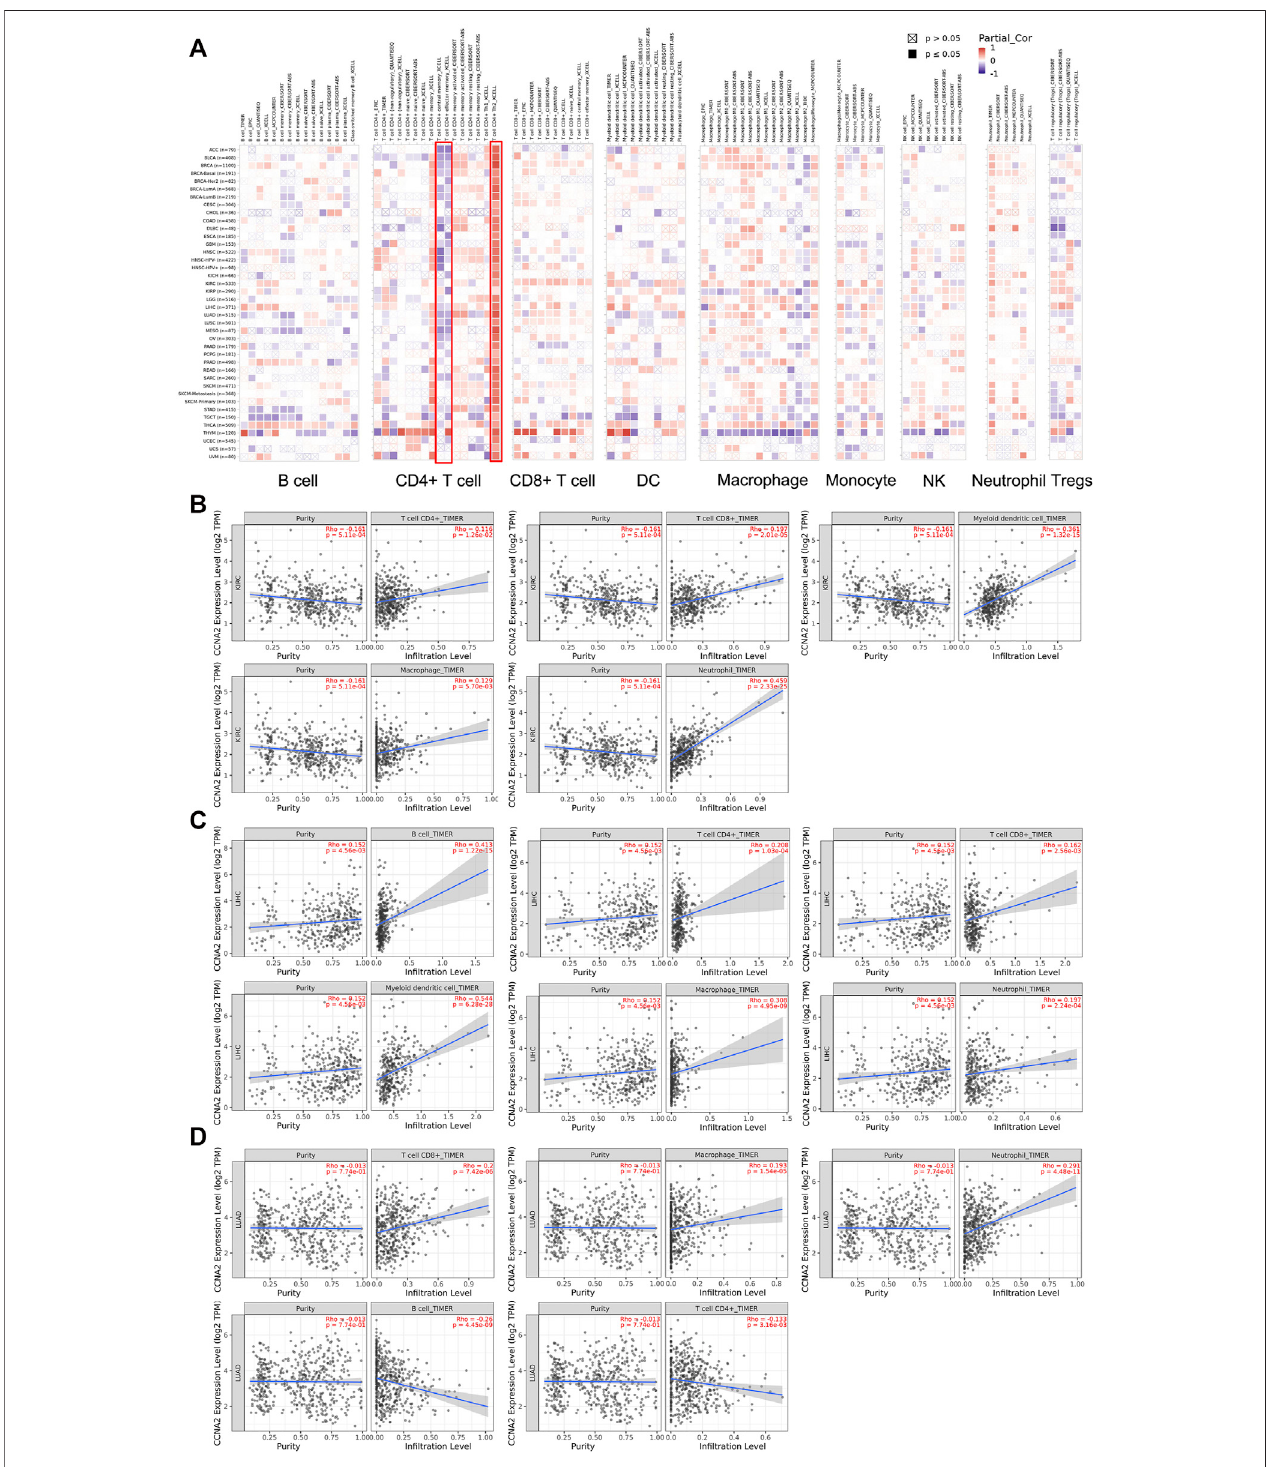
FIGURE 6 | (A) Potential correlation between the CCNA2 expression and immune cell in fi ltration in all TCGA cancer types. (B – D) The scatter plots of related cancers generated by the TIMER algorithm, indicating association between immune in fi ltrates and CCNA2 expression in KIRC (B) , LIHC (C) and LUAD (D) .